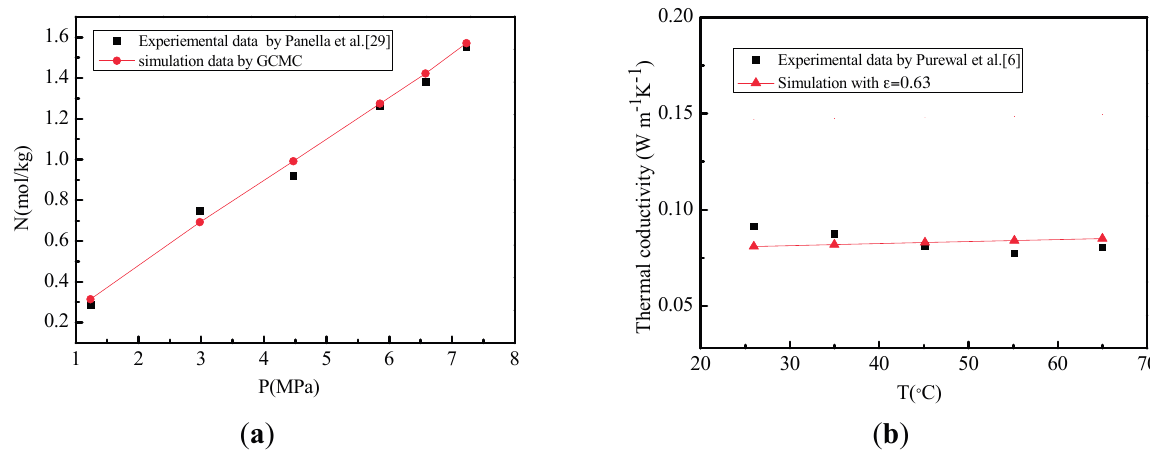
Figure 4. Comparison of simulated results and experimental data. ( a ) Comparison of simulated and experimental adsorption isotherm of H 2 in MOF-5 at 298 K; ( b ) Comparison of simulated and experimental thermal conductivity at different temperatures.